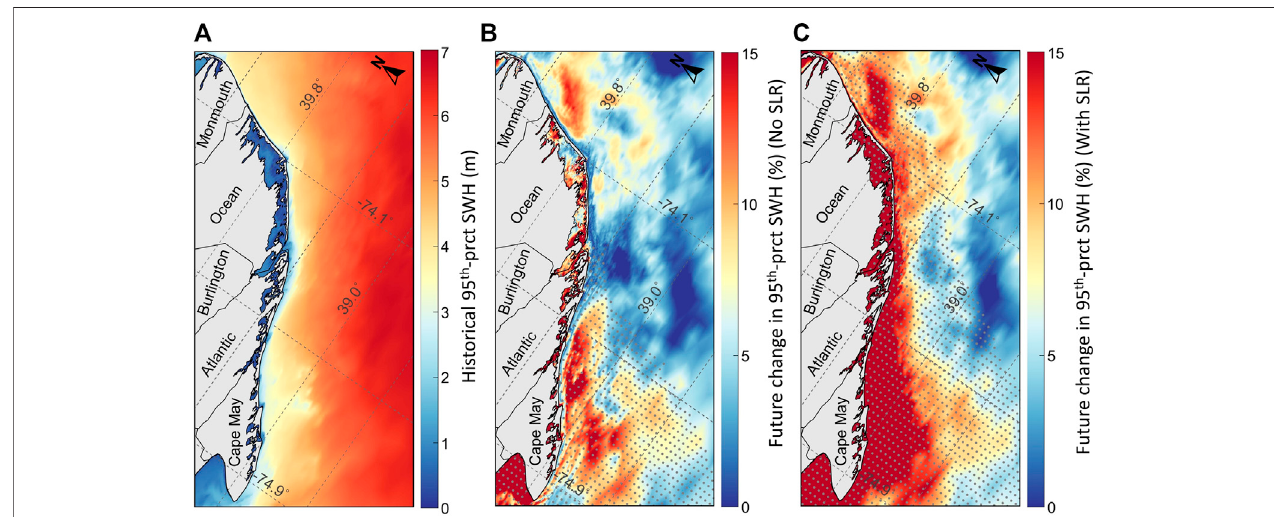
FIGURE 7 | (A) Model-based historical 95th-percentile SWH metric. (B) Projected changes by the end of 21st century under RCP8.5 scenario for the No-SLR scenario. (C) Same as (B) but for the With-SLR scenario. Stippling denotes areas where projected changes are statistically signi fi cant (with a con fi dence level of at least 95%). The scale bars in (B,C) are different from that in (A) .